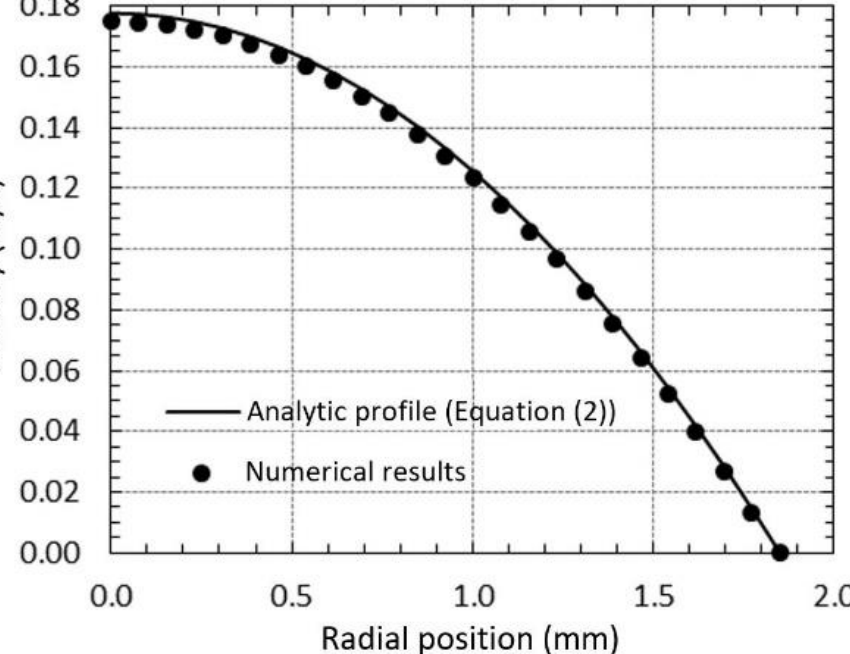
Figure 3. Velocity profile for fully developed Newtonian flow in the region before the aneurysm, u = 88.8 mm/s.